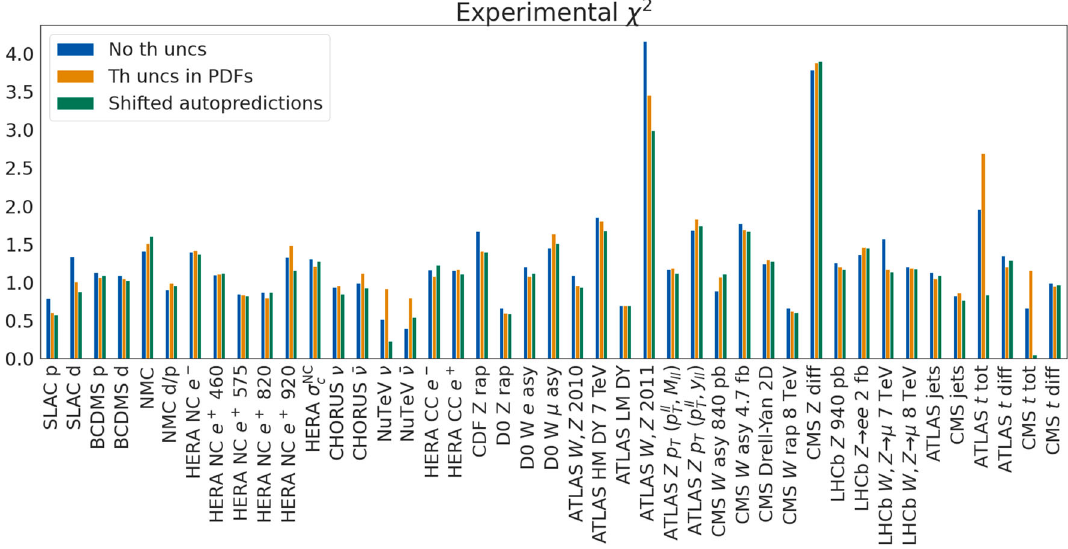
(in green), both normalized to T i